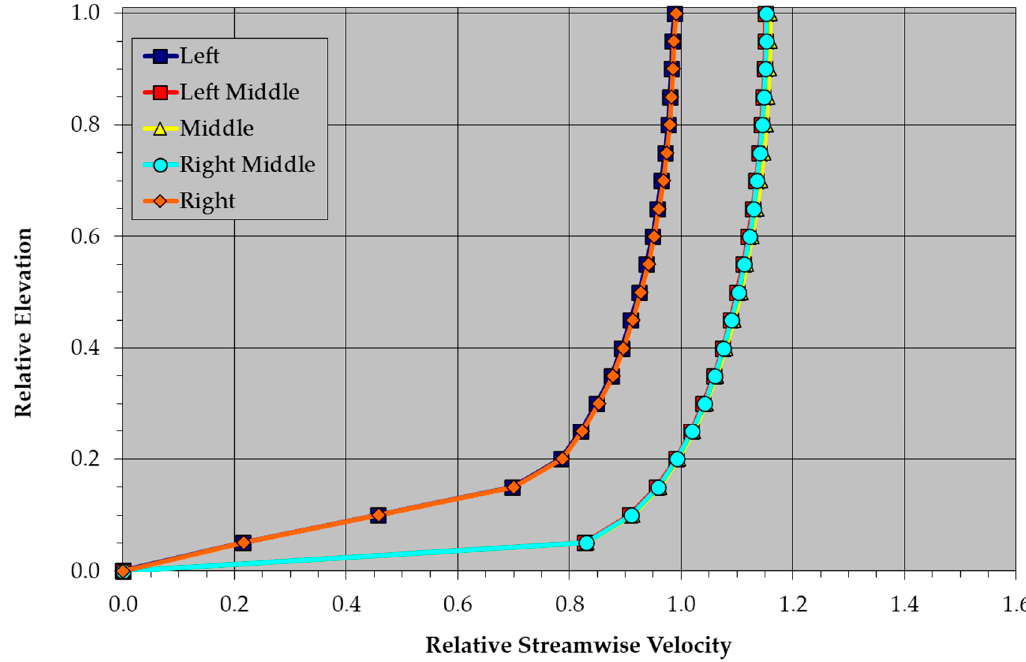
Figure 37. Vertical streamwise velocity profiles at Cross-section 112 (upstream straight reach) for Simulation Set 5 with a sinuosity of 2.75.